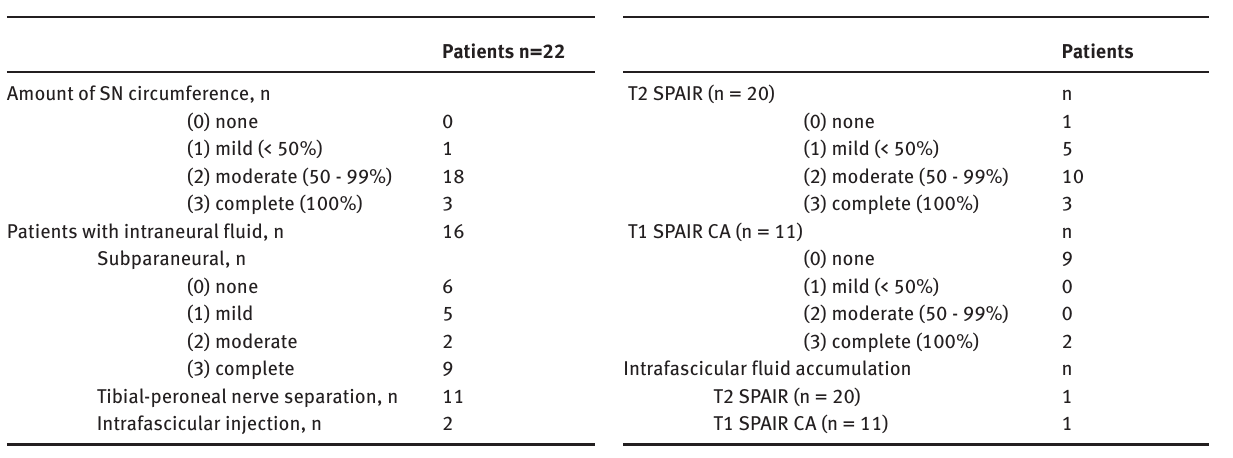
Table 4: Spread of local anesthetic around the SN assessed by sonography during injection